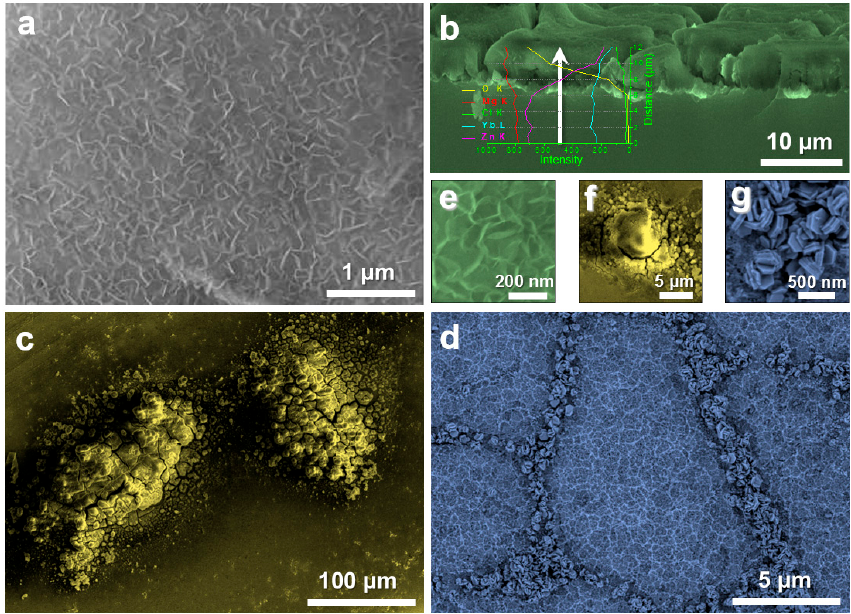
Figure 11. SEM images showing superficial morphologies of the experimental samples after immersion in 3.5 wt.% NaCl solution for 10 min: ( a ) SA treated Mg 66 Zn 30 Yb 4 GR; ( b ) cross section of the hydrophobic film and the EDS line scanning; ( c ) original Mg 66 Zn 30 Yb 4 GR; ( d ) crystalline state Mg 66 Zn 30 Yb 4 sample; ( e – g ) enlarged images of ( a , c , d ) respectively.